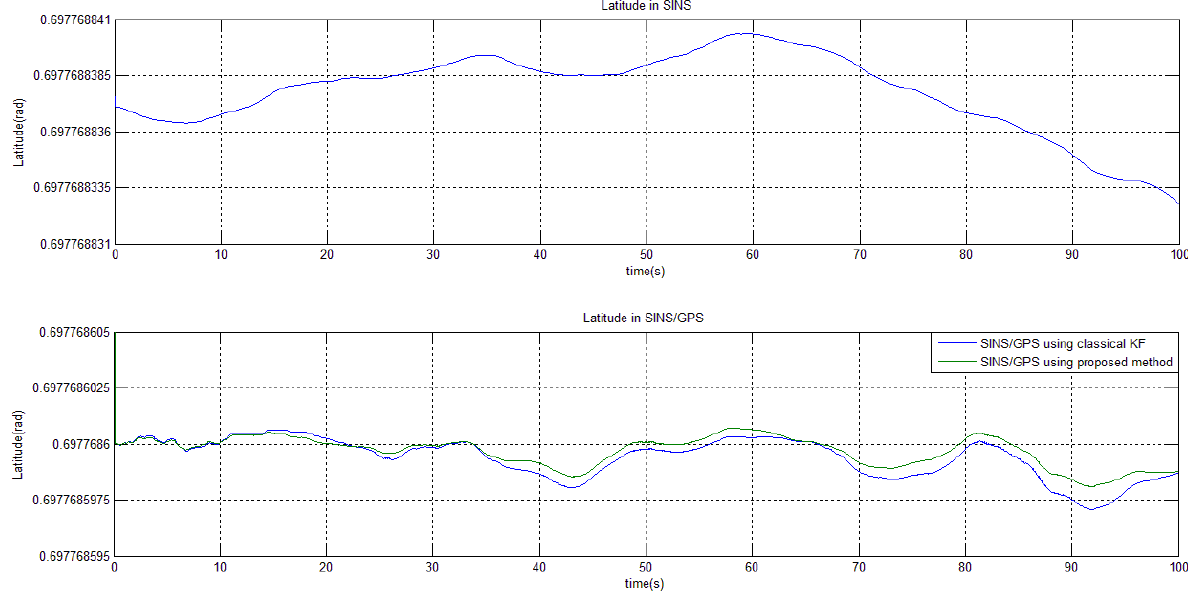
Figure 3. Latitude calculation by different